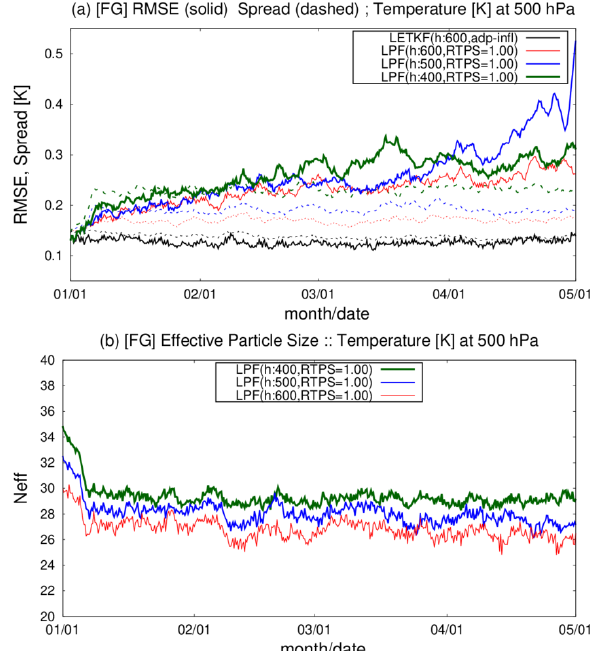
Figure 6. Time series of globally averaged background (a) RM- SEs (solid lines) and ensemble spreads (dashed lines) for T (K) and (b) effective particle size N eff at the fourth model level ( ∼ 500hPa), with REG2 observations. Black lines show the LETKF. Red, blue, and green lines are the LPF experiments, with localization scales of 600, 500, and 400km, respectively. RTPS parameter α is set to 1.00 in all three LPF experiments. The abscissa shows month and